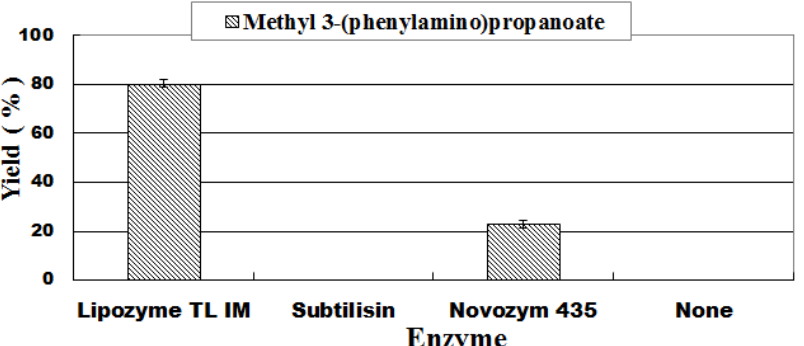
Figure 3. The catalyst screening on enzymatic synthesis of β-amino acid esters in continuous-flow microreactors.